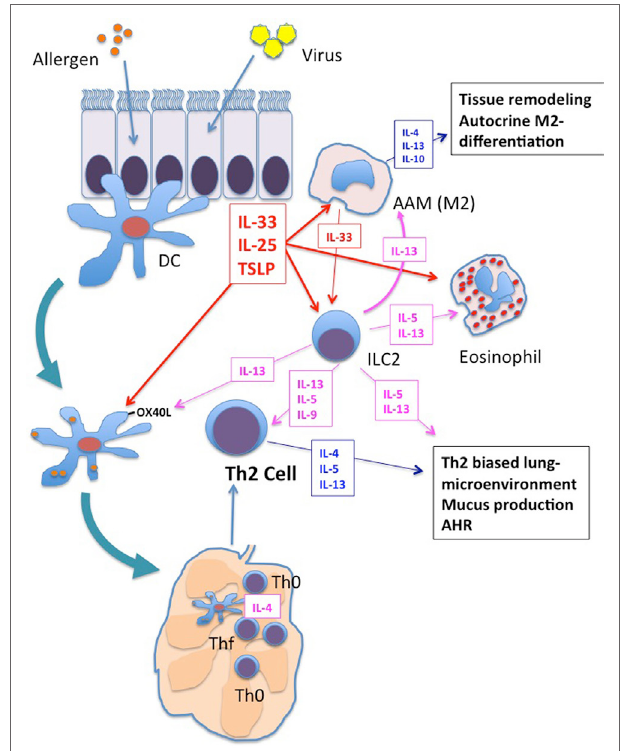
FiGURe 1 | Shared responses in lung innate cells in response to respiratory virus infection and allergen exposure. Viral infection and/or allergen exposure of bronchial epithelial cells results in the secretion of the innate type-2 cytokines: thymic stromal lymphopoietin (TSLP), interleukin (IL)-25, and IL-33. Dendritic cells (DCs), macrophages, and innate type 2 lymphoid cell (ILC2s) are among the first responders in the lung. Each of these cytokines increases activation of DCs, including increased expression of OX40L. OX40L expressing DCs drive Th2 differentiation in the lung mediastinal lymph nodes. These innate type-2 cytokines also promote differentiation of M2 alternatively activated macrophages (AAM), which secrete type-2 cytokines IL-4, IL-13, and IL-10 and orchestrate type-2 inflammation and tissue repair in the lung. M2 macrophage cytokine/chemokine production contributes to enhanced type-2 biased inflammation and airway remodeling. IL-5 and IL-13 production from ILC2s promotes eosinophil influx and responses in DCs and macrophages that further enhance type-2 inflammation, Th2 differentiation, and airway hyperresponsiveness (AHR). Each of these responses is enhanced in neonates upon exposure to respiratory viruses, setting the stage for enhanced type-2 inflammation upon exposure to